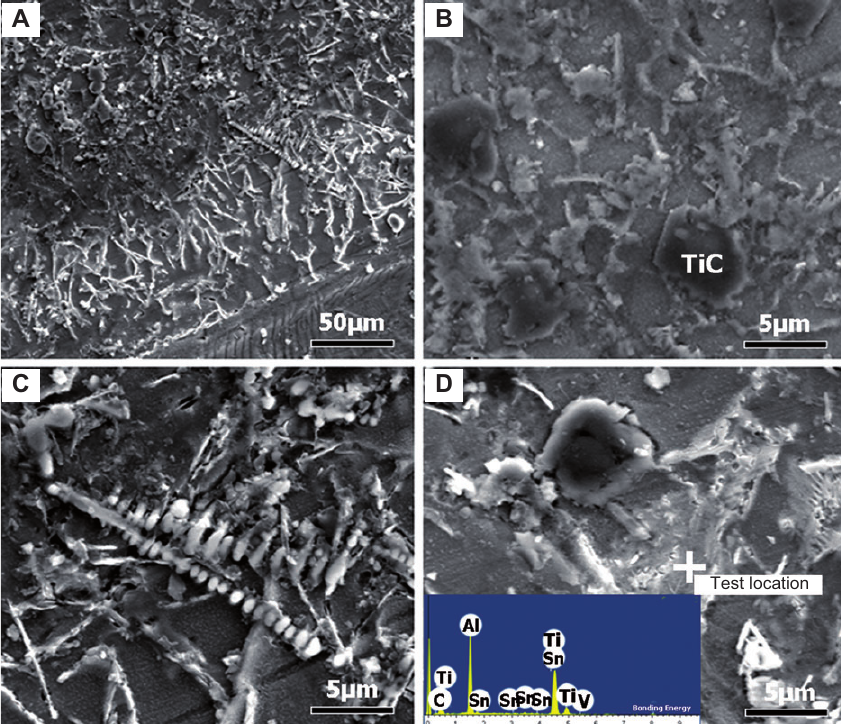
Figure 1 SEM micrographs of the laser alloying composite coating. (A) The bonding zone, (B) alloying zone, (C) TiC, and (D) test location/ EDS result.